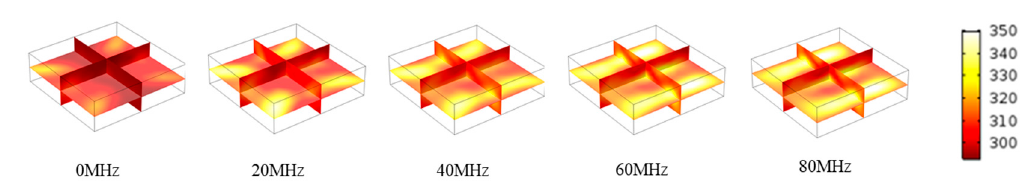
Figure 11. The heating temperature distribution under di ff erent sweep frequency bandwidths. Table 5. Simulated heating results for di ff erent sweep bandwidths.